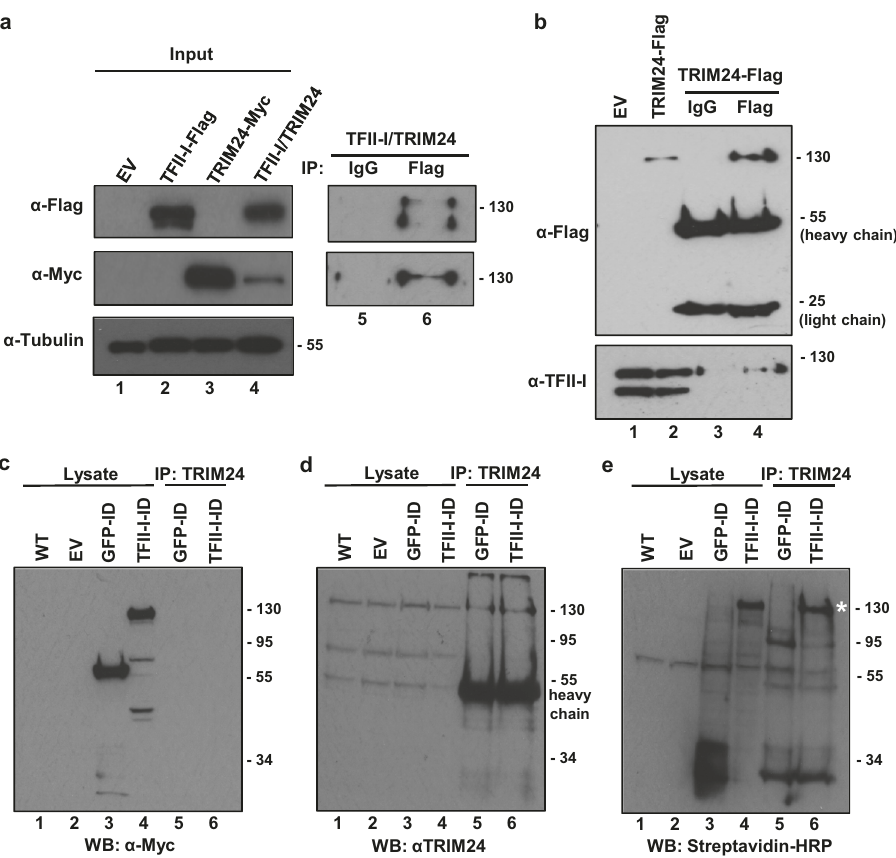
Fig. 2 TRIM24 interacts with TFII-I. a HEK293T cells were transfected with an empty vector or plasmids expressing TFII-I-Flag or TRIM24-Myc (lanes 1 – 4). Lysates were analyzed by immunoblotting with antibodies against the Flag, Myc, or Tubulin as indicated. Cells co-expressing TFII-I-Flag and TRIM24- Myc were immunoprecipitated with control (IgG) (lane 5) or Flag (lane 6) antibodies and complexes were analyzed by immunoblotting with Flag and Myc antibodies as indicated. b Lysates from Jurkat cells bearing a vector control (EV, lane 1) or a TRIM24-Flag expression vector (lane 2) were analyzed by immunoblotting with antibodies against Flag or TFII-I. Jurkat cells expressing TRIM24-Flag were immunoprecipitated with control (IgG, lane 3), or anti-Flag (lane 4) antibodies, and complexes were analyzed by immunoblotting with anti-Flag or anti-TFII-I antibodies as indicated. c – e HEK293T (lane 1) or cells expressing GFP-TurboID-Myc (lanes 3 and 5), TFII-I-TurboID-Myc (lanes 4 and 6), or an empty vector (lane 2) were incubated with 500 µ M biotin for 1 h. Cell lysates (lanes 1 – 4) or TRIM24 immunoprecipitants (lanes 5-6) were analyzed by immunoblotting with antibodies against Myc ( c ), TRIM24 ( d ), or with Streptavidin-HRP ( e ). Biotinylated TRIM24 is indicated with a white asterisk ( e , lane 6, ~130